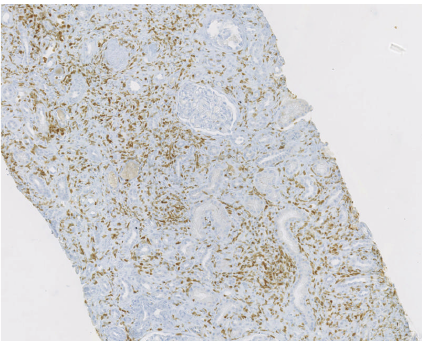
Figure 2: Kidney biopsy. Optical microscopy showed significant interstitial CD3 + infiltration (immune-staining CD3 polyclonal, Dako,